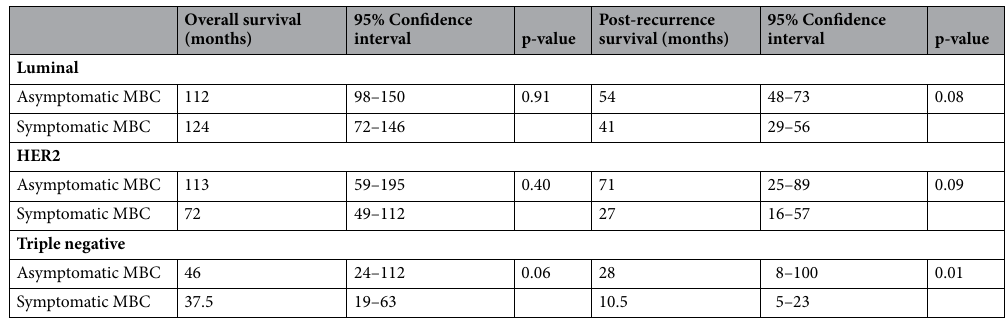
Table 3. Comparison of OS and PRS between the asymptomatic and symptomatic MBC groups according to subtype. HER2 human epidermal growth factor receptor 2, MBC metastatic breast cancer, OS overall survival, PRS post-recurrence